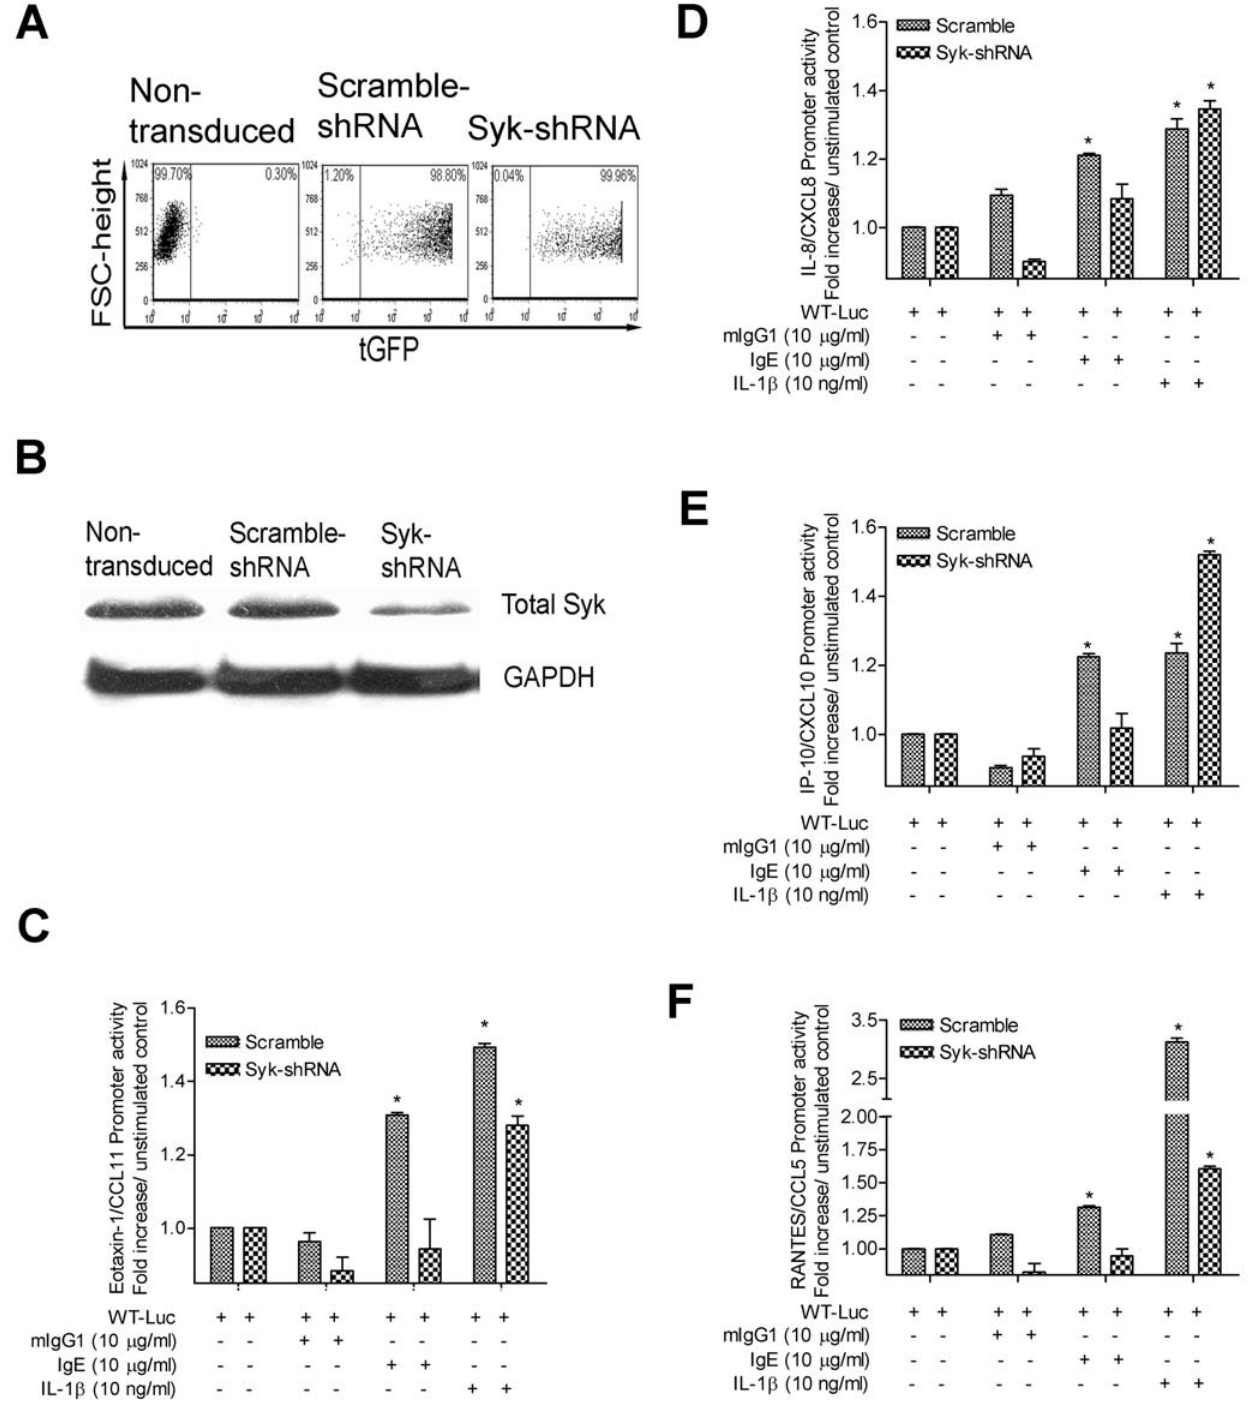
Figure 5. Lentivirus-mediated Syk shutdown abrogates the IgE-induced chemokines promoter activity in human B/TSM cells. Human B/TSM cells were first transduced with a pseudotyped Lentiviral vector expressing specific Syk-shRNA or a non-specific scramble-shRNA. (A) The Lentiviral transduction efficiency was more than 95% for both scramble-shRNA and Syk-shRNA as determined by FACS using the tGFP as the marker for cell sorting. (B) Lentiviral Syk-shRNA transduction in B/TSM cells silenced the Syk expression efficiently as observed by Western blotting. Syk- and scramble-transduced human B/TSM cells were then transiently transfected with luciferase reporter constructs driven by wild-type promoters for human (C) eotaxin-1/CCL11, (D) IL-8/CXCL8, (E) IP-10/CXCL10, or (F) RANTES/CCL5; stimulated with mIgG1-MOPC21, IgE, or IL-1 b for 12 h; and respective chemokine promoter activity was measured as mentioned in Materials and Methods . Data were normalized according to the Renilla luciferase activity, and presented as fold-increase over unstimulated control. Data represents the mean 6 SD of three separate experiments. Mann- Whitney U test was performed to analyze the differences between the samples. * P , 0.05, ** P , 0.01 compared to unstimulated control.